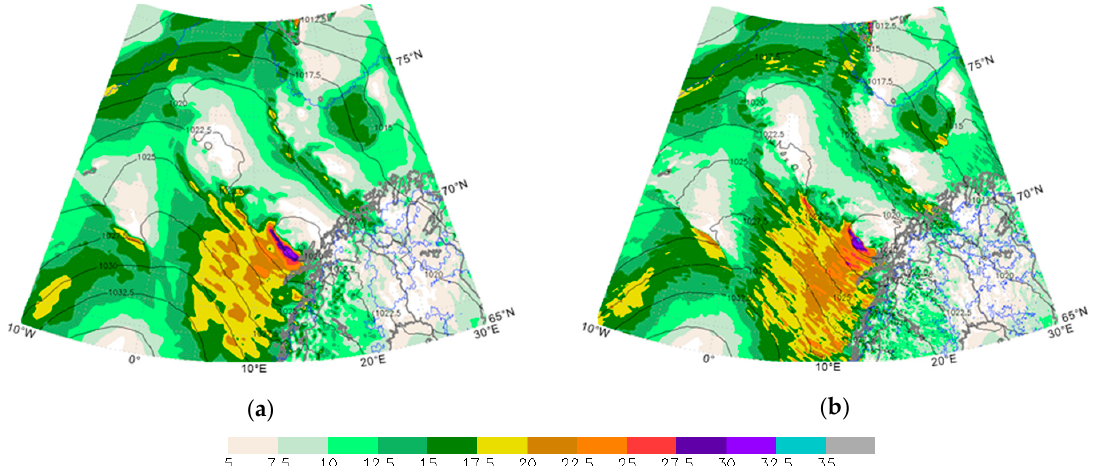
Figure 14. ICON ‐ A6.5 ( a ) and ICON ‐ A2 ( b ). Forecast of wind gusts and sea ‐ level pressure base time: 00:00 UTC 20